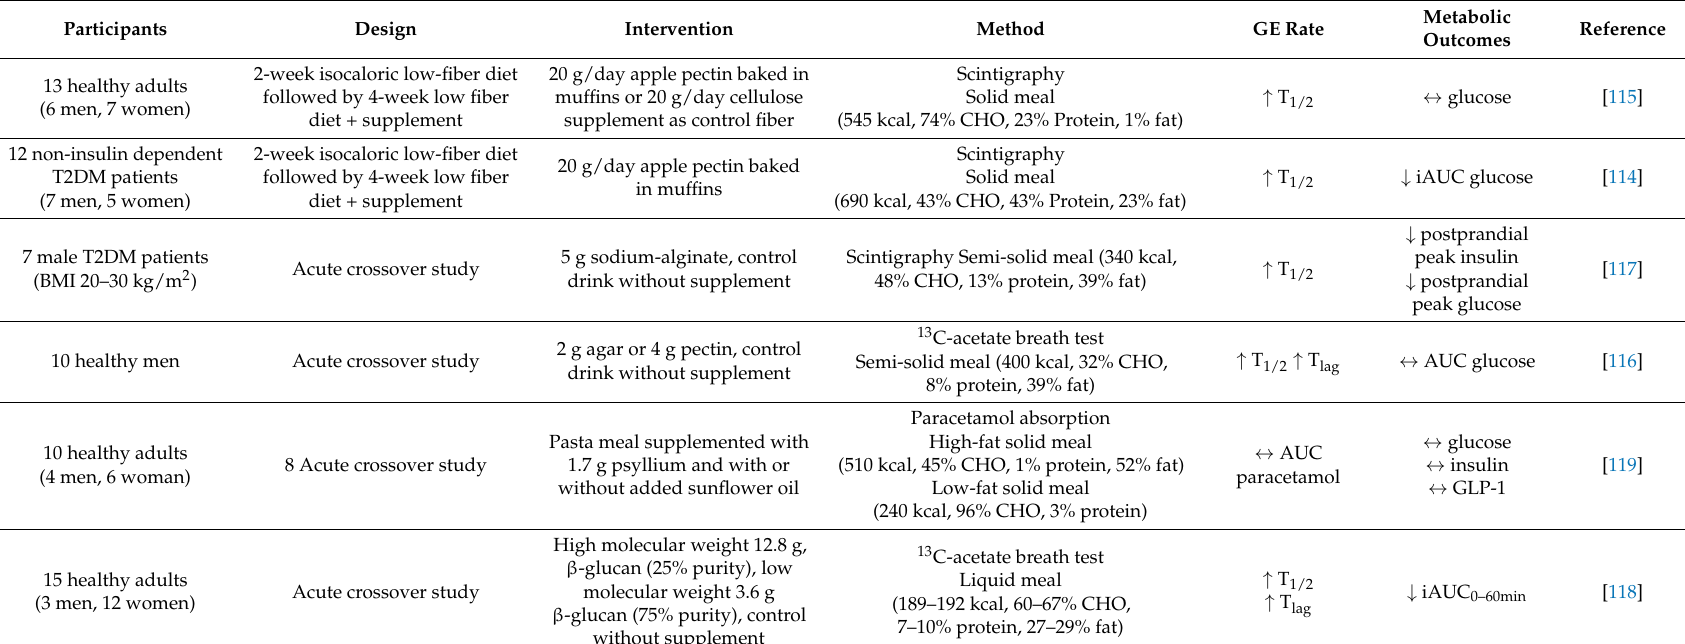
Table 1. Summary of human intervention studies with viscous dietary fiber on GE rate and postprandial glucose metabolism.